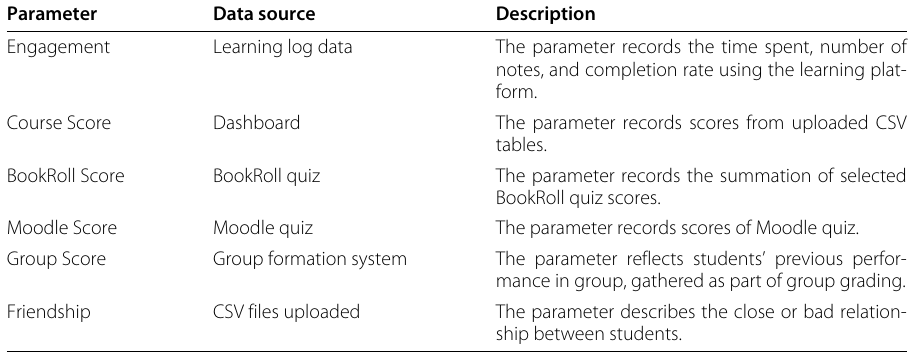
Table 3 Parameters used in the group formation